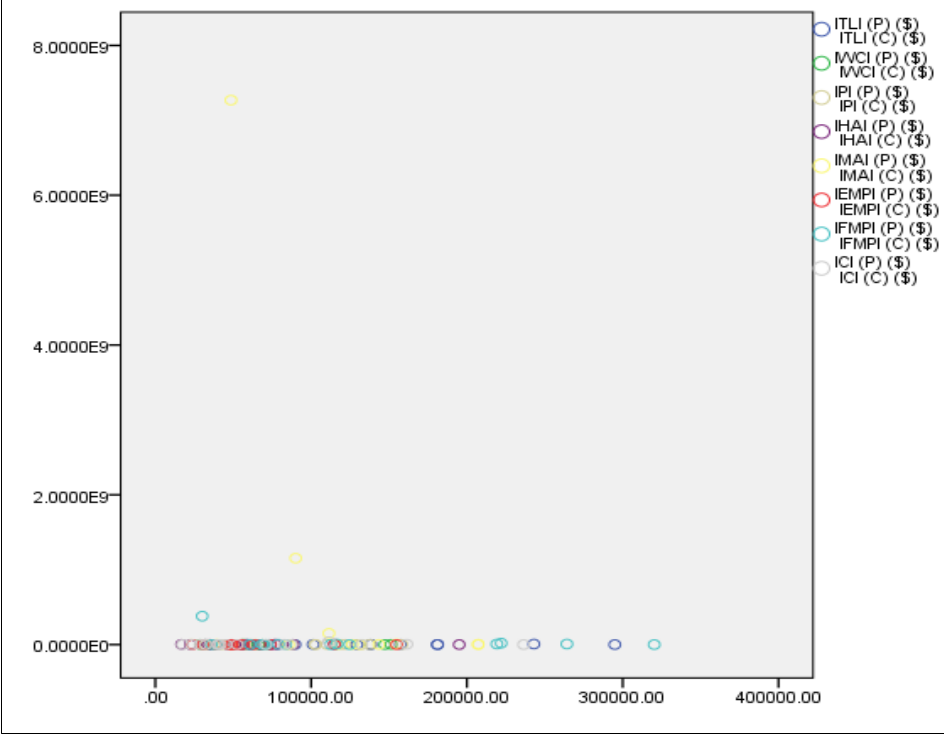
Figure 8: The scatter plot of cost versus